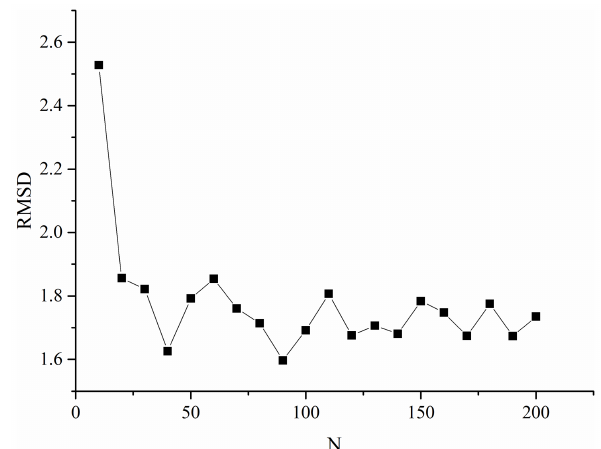
Figure 4. RMSD of the estimation with respect to particle numbers. The value is relatively high when the particle number is fewer than 20 and tends to be stable when higher than